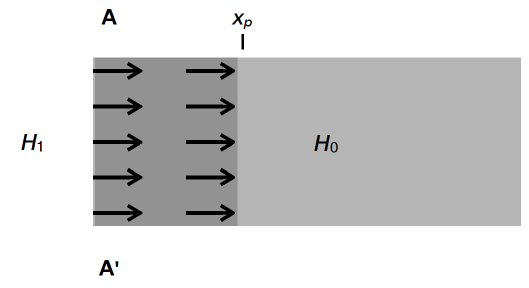
Figure 1. A thick slab of uniform material conditioned at humidity and subject to a step increase of humidity to marks the penetration depth of the advancing sorption 𝑥𝑥 𝑝𝑝